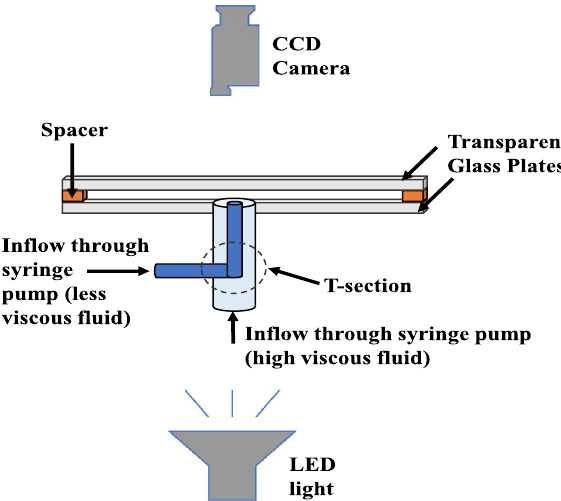
Figure 9. Hele–Shaw cell utilised in the experiments, shown schematically.